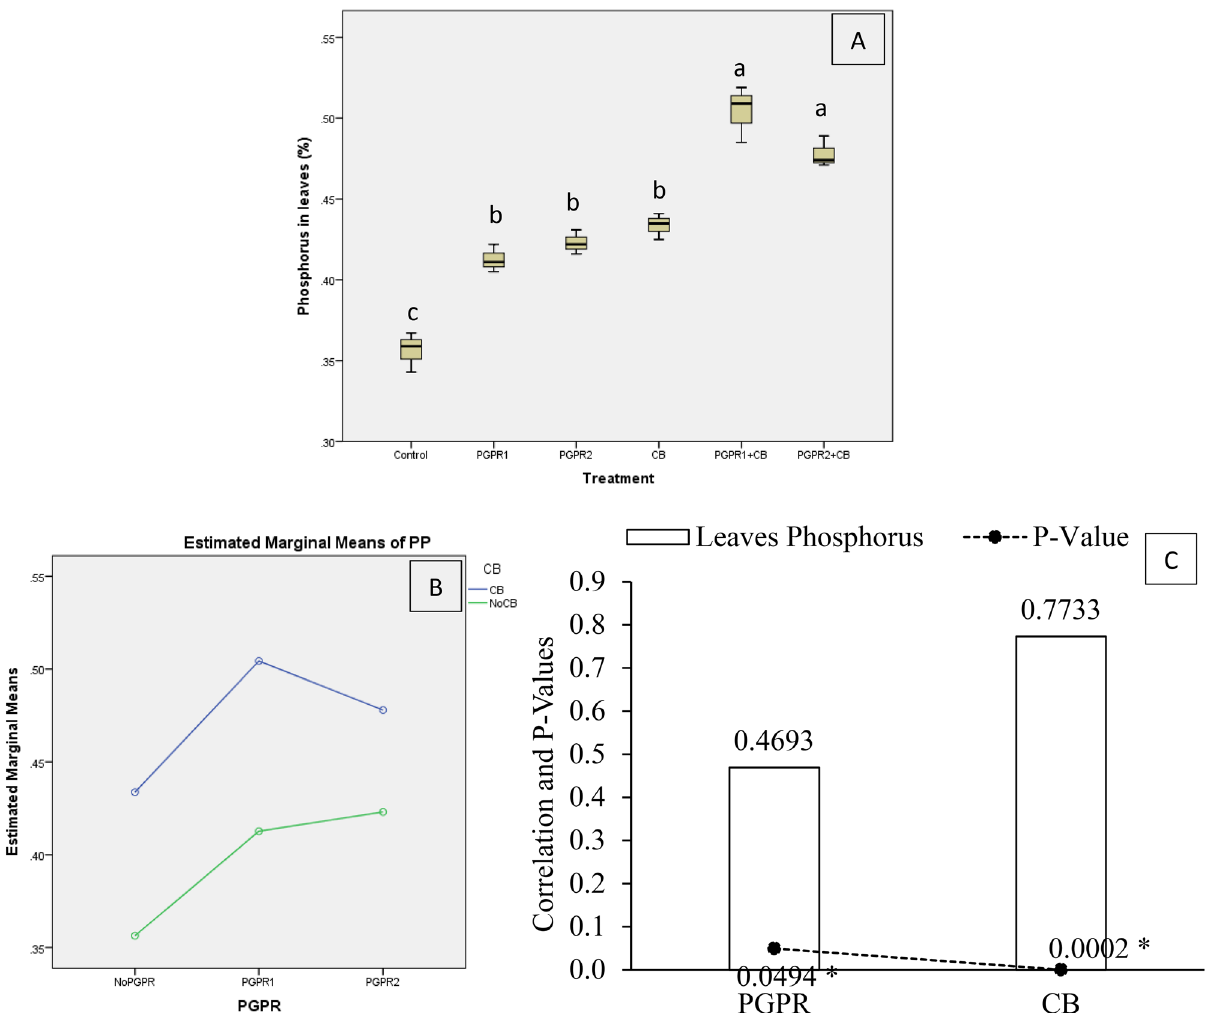
Figure 13. Effect of treatments on mint plants leaves phosphorus concentration (PP). Values are the average of three replicates ( A ). Different letters showed significant differences (Tukey’s test; p ≤ 0.05). Interaction graph of PGPR and CB for soil PP ( B ). Correlation graph of PGPR and CB for soil PP ( C